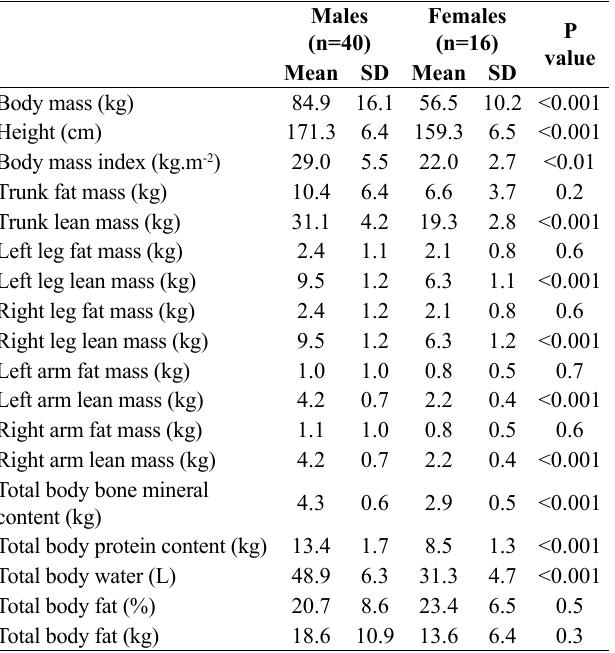
Table 3. Body composition characteristics of male and female pow-